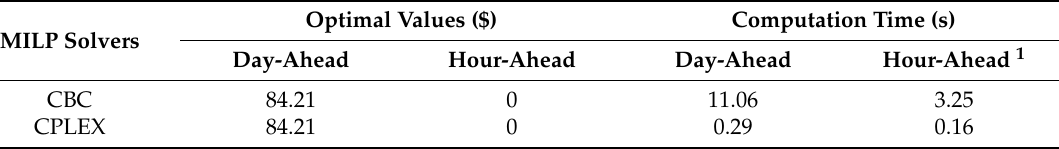
Table 5. Comparison results of CBC and CPLEX.